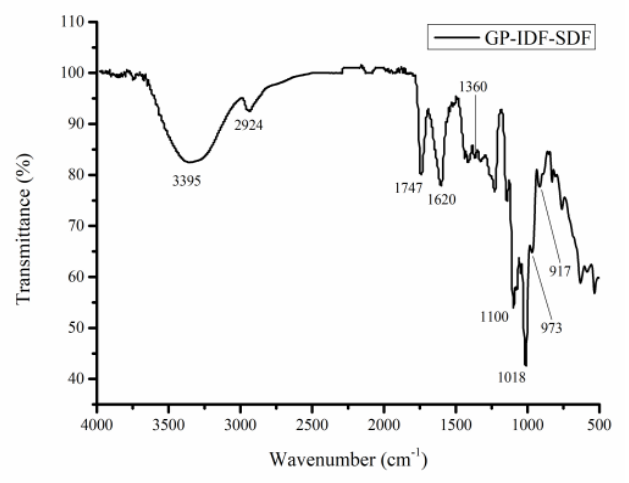
Figure 4. FT-IR spectrum (c) of GP-IDF-SDF.